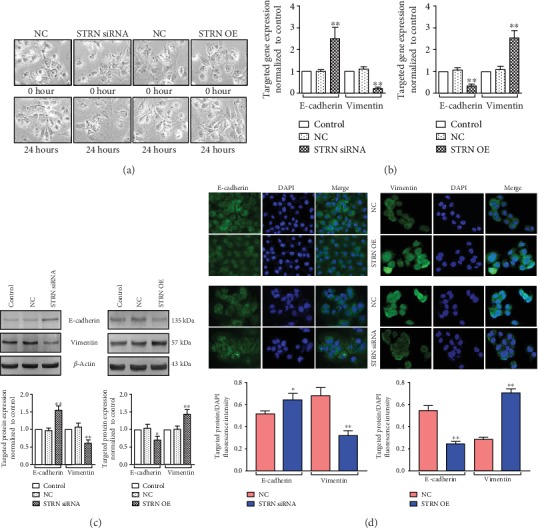
Modulation of STRN expression in Huh7 cells influences the EMT or MET process in vitro. (a) Morphological changes of Huh7 cells with STRN downregulation and overexpression were observed by microscopy, and representative images are shown (original magnification, ×200). (b) qRT-PCR assay was performed to measure the mRNA level of the epithelial marker E-cadherin and the mesenchymal marker Vimentin in Huh7 cells with dual-directional regulation of STRN expression. (c) Effect of STRN on the expression of EMT-related proteins. E-cadherin and Vimentin were examined in Huh7 cells with STRN downregulation and overexpression by Western blot analysis. (d) Immunofluorescence assay was performed to assess the expression of markers of epithelial and mesenchymal phenotypes (original magnification, ×200). ∗P < 0.05 and ∗∗P < 0.01vs. either control or NC (b, c); ∗P < 0.05 and ∗∗P < 0.01vs. NC (d). Abbreviations: NC: negative control; OE: overexpression.